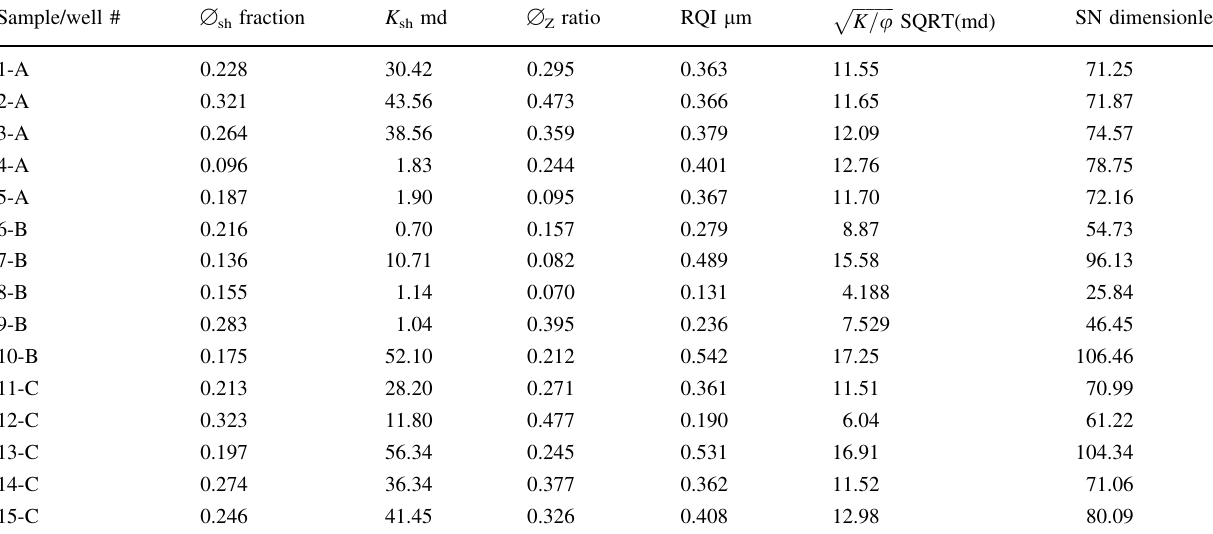
Table 1 Rock properties of actuals samples